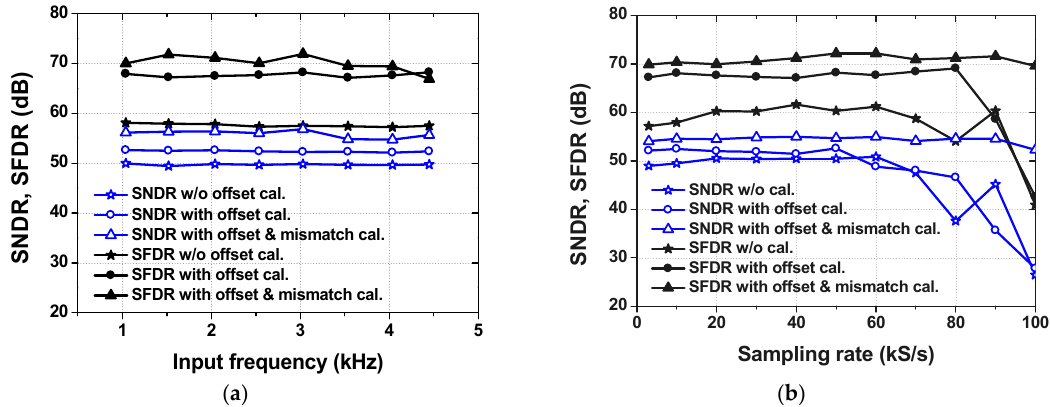
Figure 22. Measured signal-to-noise and distortion ratio (SNDR) and spurious-free dynamic range (SFDR) as a function of ( a ) input frequencies with f S = 9 kS/s, ( b ) sampling rates with f IN = 1.35 kHz.